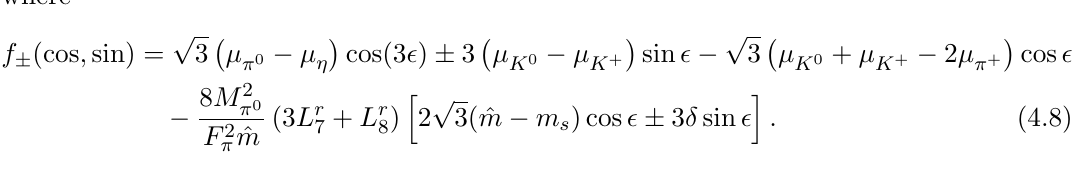
Figure 1 . Feynman diagrams for the computation of the axion-photon coupling up to O the dashed lines denote Goldstone bosons and wavy lines photons. Only pseudoscalar mesons are running in the